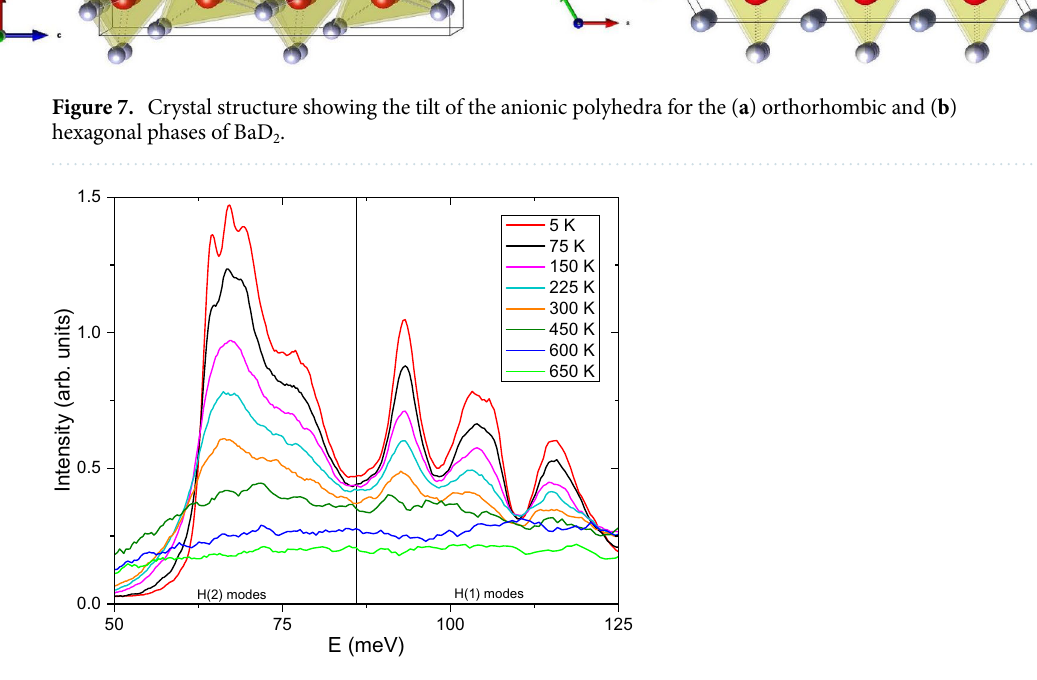
Figure 8. Inelastic neutron scattering spectra from 5 to 650 K for BaH 2 measured at VISION. The optical phonon modes corresponding to H(1) and H(2) sites are